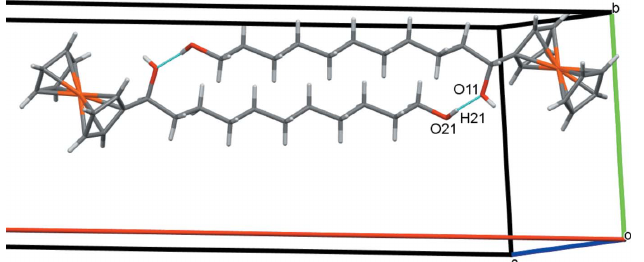
Figure 4 Double chains of molecules of 1 along c. Cg 2 is the centroid of the C6– C10 cyclopentadienyl ring, shown here as red spheres, with the C—H (cid:2)(cid:2)(cid:2) (cid:2) contacts drawn as dashed red